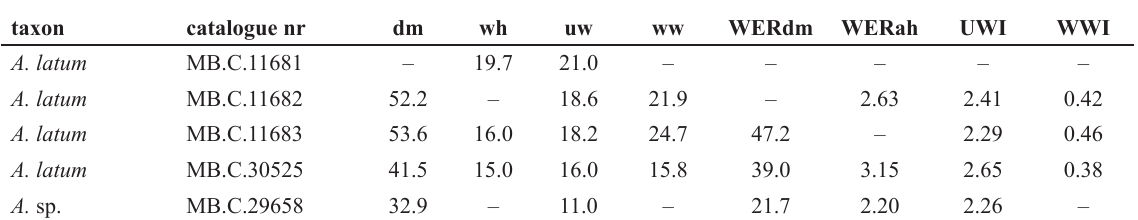
Table 7. Conch measurements (in mm), ratios and rates of coiled conch parts of Angelinoceras Hyatt, 1894.